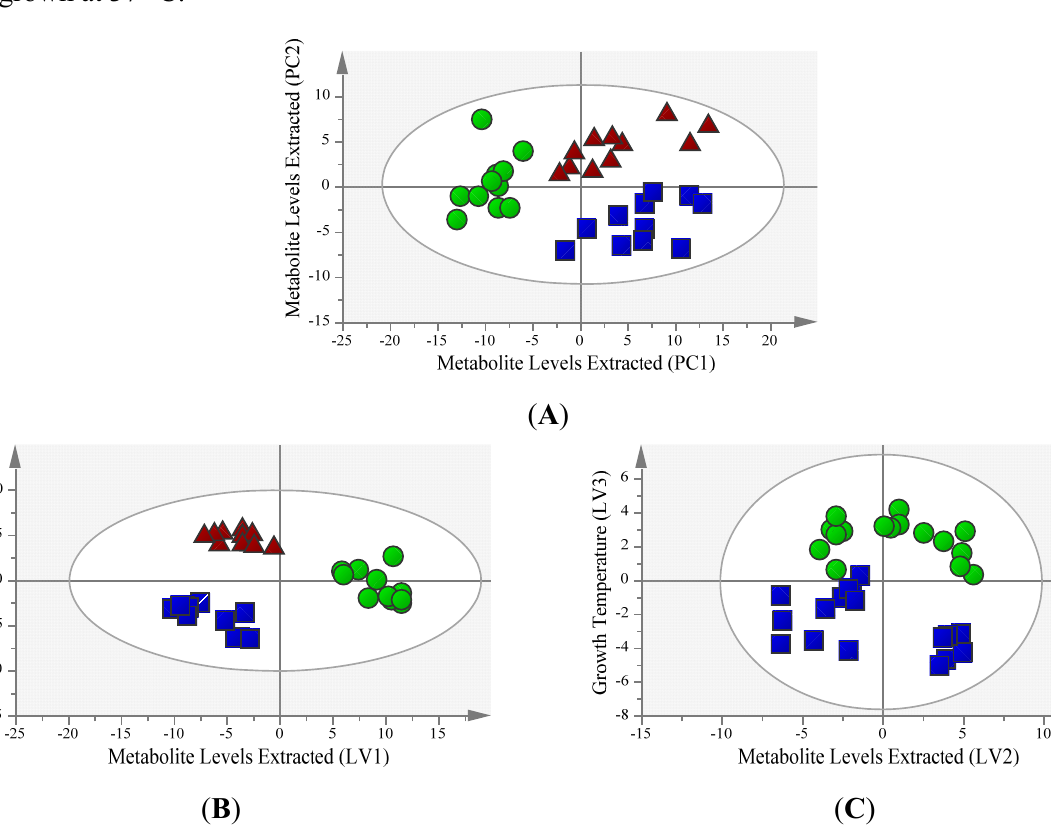
Figure 1. Models for polar metabolites extracted from S. cerevisiae by one of three chloroform/methanol/water based extraction protocols. An overview of the data confirms that there are no outlying samples within a 95% confidence interval. ( A ) PCA scores plot model with R 2 = 0.557 and Q 2 = 0.438 values. Green circles represent samples extracted using method 1, blue squares represent samples extracted using method 2 and red triangles represent samples extracted using method 3. ( B ) Orthogonal partial least squares discriminant analysis (OPLS-DA) scores plot model of predictive latent variables (LV) 1 and 2 showing separation based on extraction method with R 2 (X) = 0.704, R 2 (Y) = 0.933, Q 2 = 0.881 and cross validated analysis of variance (CV-ANOVA) p = 4.20 × 10 − 7 values. Green circles represent samples extracted using method 1, blue squares represent samples extracted using method 2 and red triangles represent samples extracted using method 3. ( C ) OPLS-DA scores plot model of predictive latent variables (LV) 2 and 3 showing separation based on growth temperature with R 2 (X) = 0.704, R 2 (Y) = 0.933, Q 2 = 0.881 and CV-ANOVA p = 4.20 × 10 − 7 values. Green circles represent samples grown at 30 °C, blue squares represent samples grown at 37